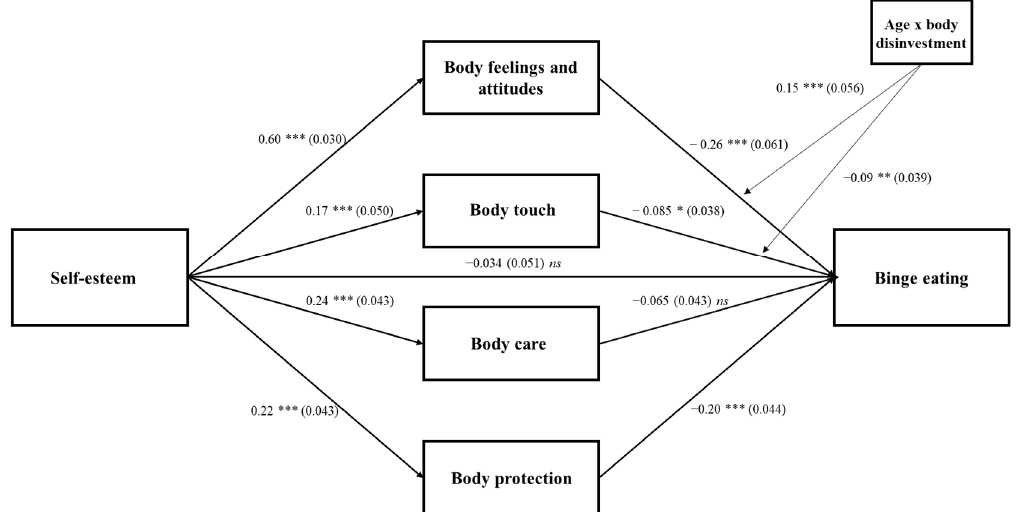
Figure 3. Males model: Standardized path analysis coefficients and standard errors * p < 0.05, ** p < 0.01, *** p < 0.001, ns — not significant.